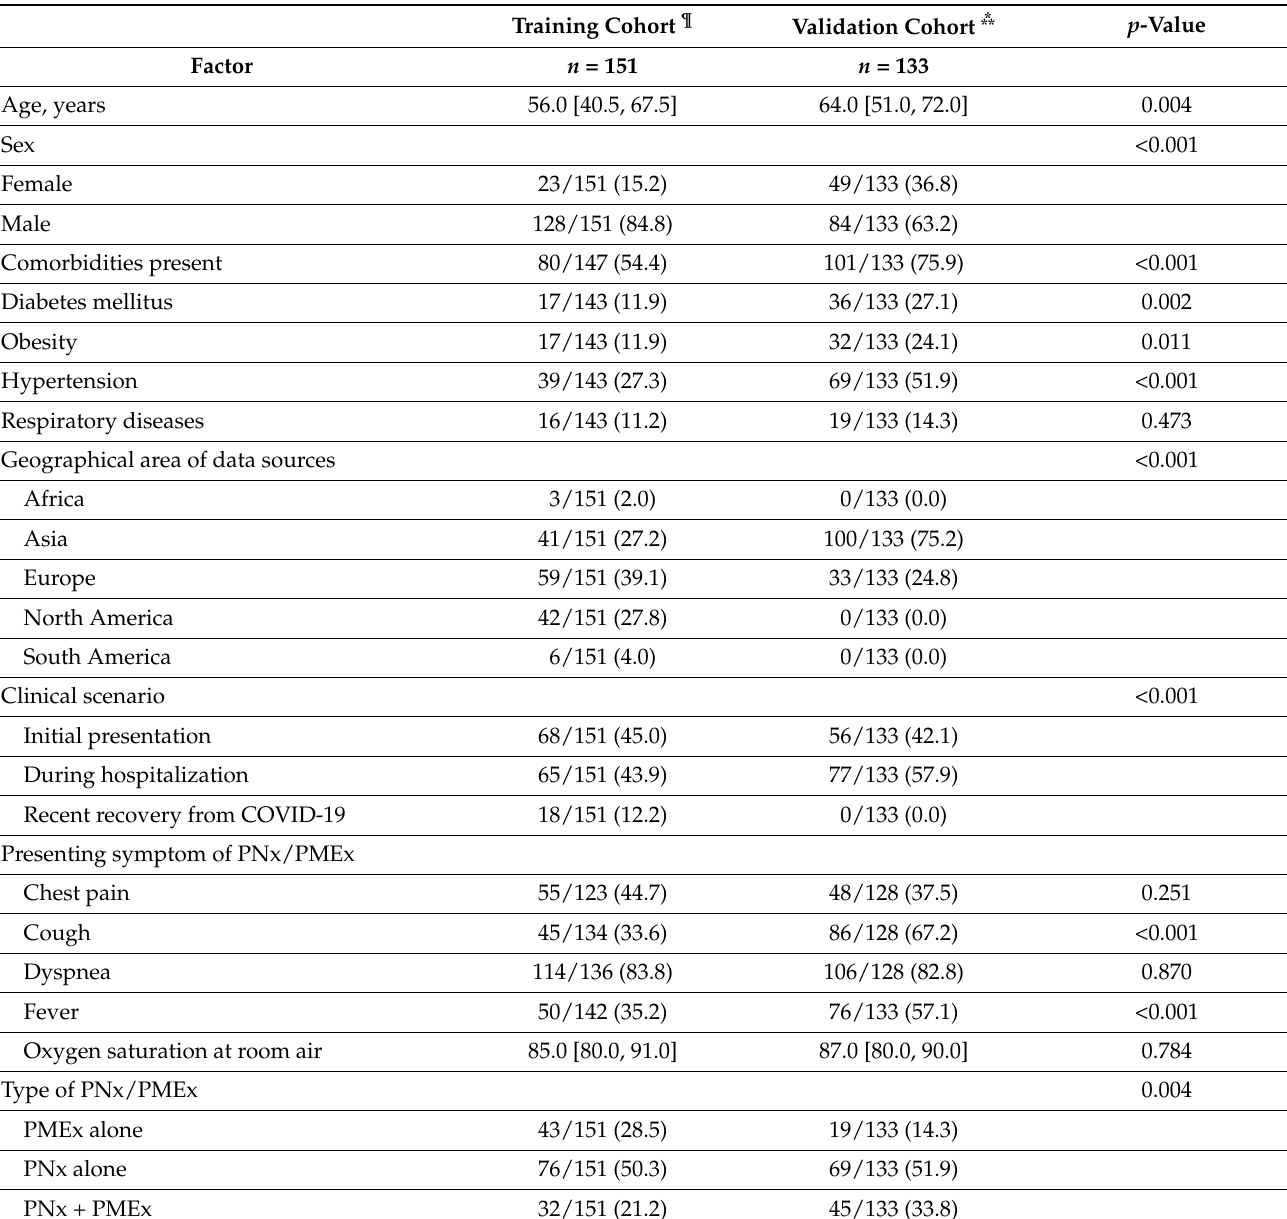
Table 4. Clinical characteristics and outcomes of patients: comparison of the training and validation cohorts.